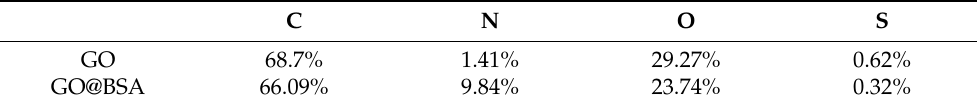
Table 1. Summary table composition of each substance.